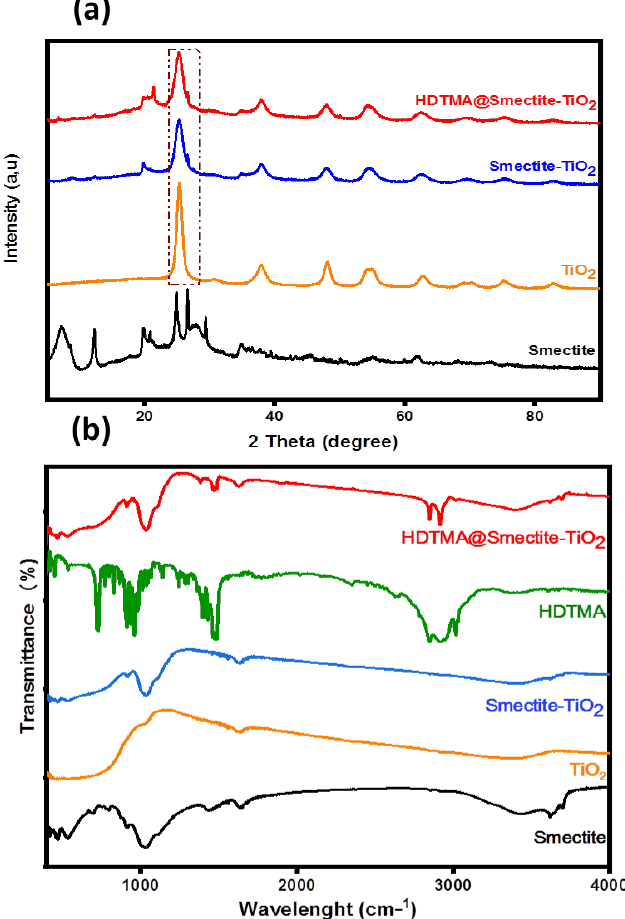
Figure 1. ( a ) XRD patterns of Smectite, TiO 2 , Smectite-TiO 2 , and HDTMA@Smectite-TiO 2 . ( b ) FTIR spectra of Smectite, TiO 2 , Smectite-TiO 2 , HDTMA, HDTMA@Smectite-TiO 2 samples. The results of the survey XPS analysis carried out on TiO 2 , Smectite-TiO 2 , and the HDTMA@SmectiteTiO 2 samples are presented in Figure 2a. Spectra of Ti2p (Figure 2b) in different photocatalysts display spin-orbit peaks due to Ti(2p3/2) and Ti(2p1/2) having a slitting value of around 5.7 eV, confirming the generation of the anatase phase. The binding energies are found at ∼ 458.6 eV and ∼ 464.1 eV for Ti 2p 3/2 and Ti 2p 1/2 , respectively. In terms of Smectite-TiO 2 and the HDTMA@Smecite-TiO 2 , the positions of Ti 2p 3/2 and Ti 2p 1/2 are slightly shifted due to the interactions between TiO 2 and smectite’ elements or/and HDTMA, which may influence the electronic state of the Ti element in the TiO 2 lattice. The HDTMA@Smecite-TiO 2 spectrum shows a significant decrease in the intensity of Ti 2p 3/2 and Ti 2p 1/2 peaks because of the dilution effect. O1s spectrum of TiO 2 displays one peak located at a binding energy of around 530.2 eV, which is due to Ti-O-Ti units in the TiO 2 lattice. This peak is positively shifted in the cases of Smectite-TiO 2 and